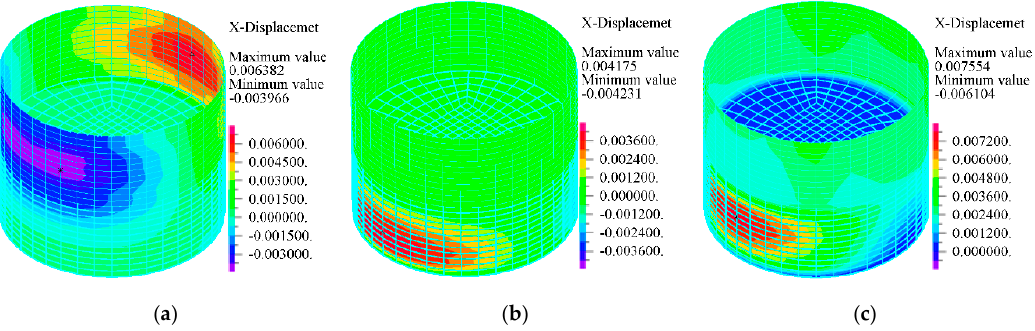
Figure 6. Comparison of tank effective stress (unit: Pa). ( a ) Wind. ( b ) Earthquake. ( c ) Wind and earthquake.